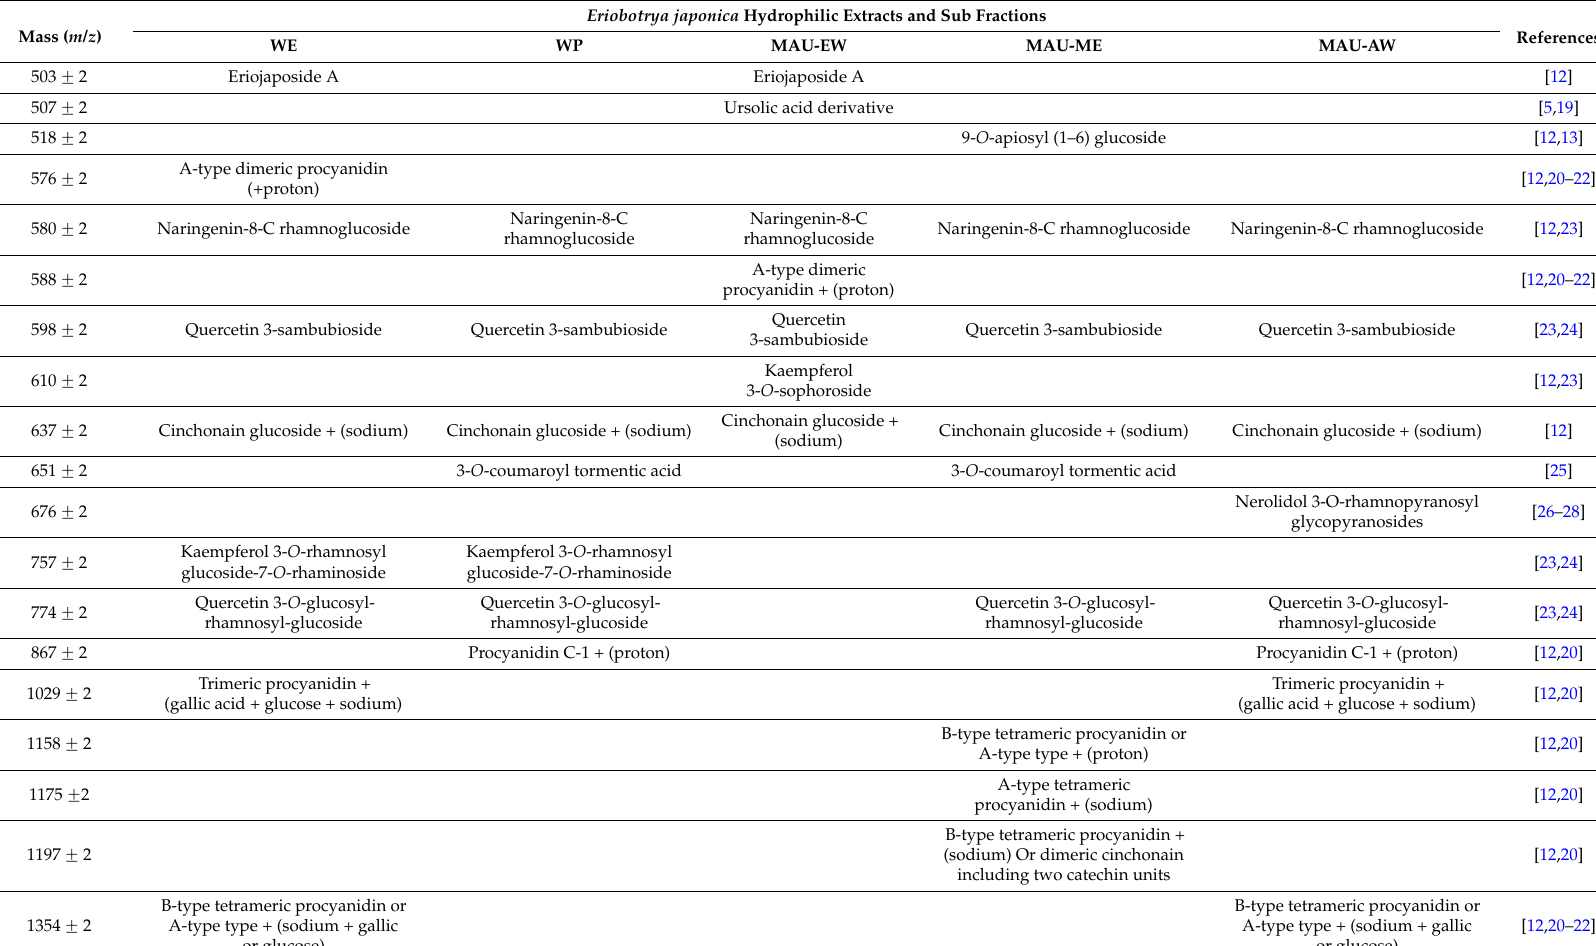
Table 3. Tentative interpretation of MALDI-TOF MS peaks in the WE, WP, MAU-EW, MAU-ME and MAU-AW